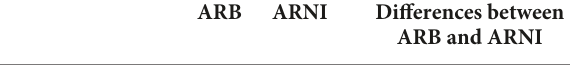
TABLE 3 Differences in rhythm and clinical events between